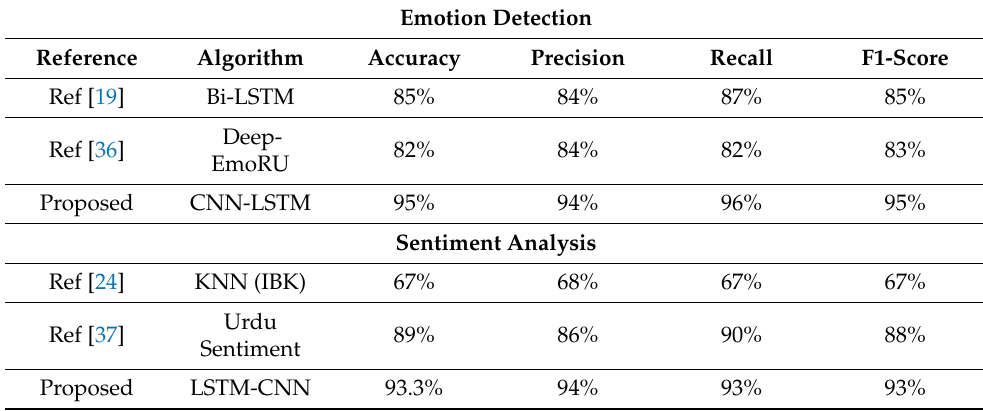
Table 10. Comparative Analysis with Previous